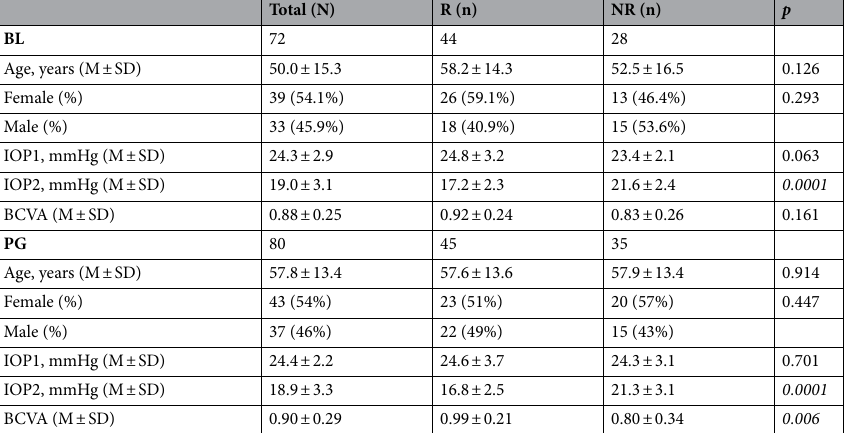
Table 1. Demographic and clinical characteristics of study cohort. BL, beta-blocker (timolol maleate) treatment group; PG, prostaglandin analogue (latanoprost) treatment group; R, responder individuals; NR, non-responder individuals; (N)(n), number of individuals; IOP1, intraocular pressure before treatment; IOP2, after treatment; BCVA, best corrected visual acuity (decimal); M ± SD, mean ± standard deviation; p, p-value for responders vs